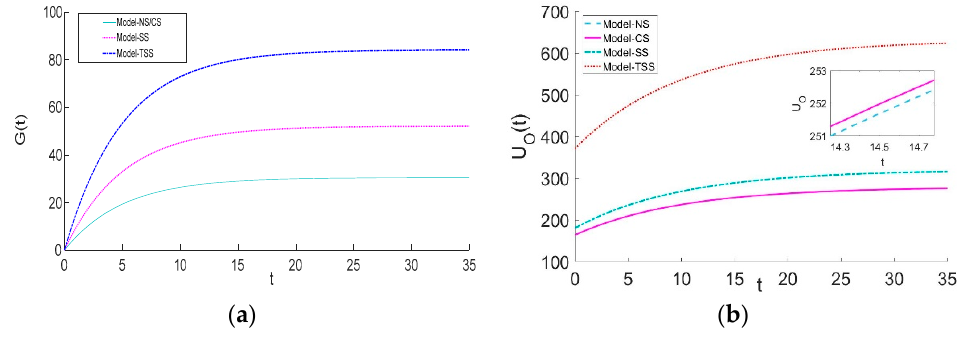
Figure 2. Time trajectory of the greenness level and system utility under four scenarios. ( a ) Greenness level. ( b ) System utility.